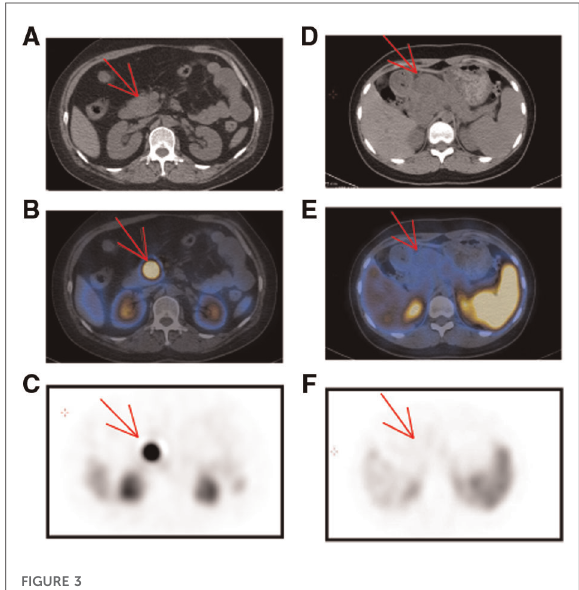
FIGURE 3 Characteristics of pNET and SPT in 99m Tc-HYNIC-TOC PET/CT. ( A – C ) A 47-year-old woman was suspected of pNET in the pancreatic head. Upon noncontrast CT examination, a predominant solid and regular shape mass was observed [( A ), arrow]. In the 99m Tc- HYNIC-TOC PET/CT fusion images, there was intense activity in the pancreatic head [( B ), arrow]. ( D – F ) SPT in a 14-year-old girl with abdominal pain. Upon unenhanced CT examination, a